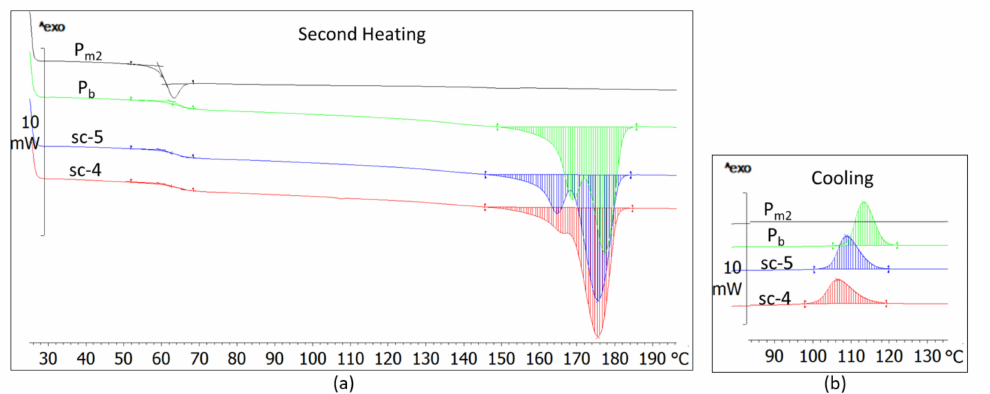
Figure 4. DSC thermograms of the sc-4 and sc-5 compounds and those of the blended polymers (Pb, P m2 ) after the second heating (10 ◦ C/min) ( a ) and the cooling (2 ◦ C/min) ( b ). Table 4. DSC behavior of the sc-4 and sc-5 compounds and those of the blended polymers (P b and P m2 ). Sample